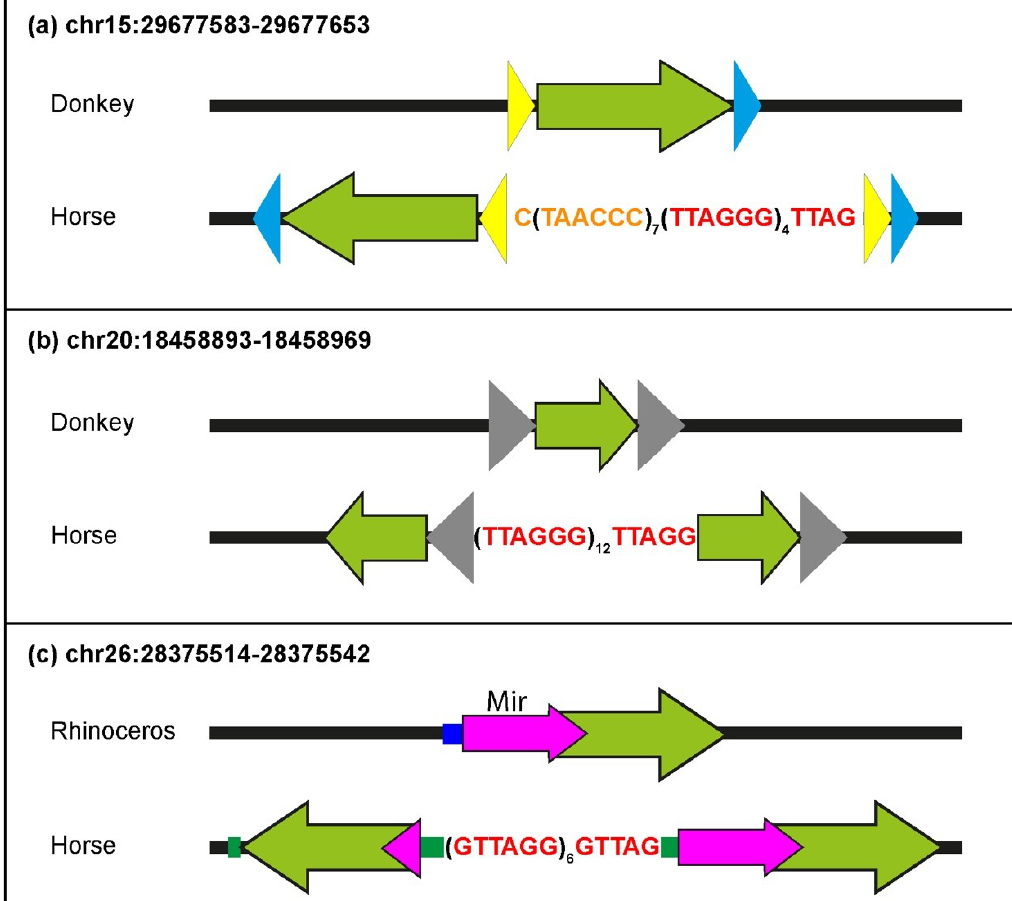
Figure 4. ITS insertions accompanied by complex rearrangements. Telomeric repeat insertions were accompanied by complex modifications of the break site involving addition of random nucleotide sequences, deletion of nucleotides from the insertion site, inversions or generation of inverted duplications. ( a ) Telomeric repeat insertion was accompanied by inversion of a single copy sequence (light green arrow) and generation of inverted duplications (yellow and light blue arrowheads) of sequences present at the empty locus. The rearrangement also caused the formation of telomeric stretches with head-to-head orientation. ( b ) The ancestral ITS-less locus from donkey contains a single copy sequence (light green arrow) flanked by short direct repeats (grey arrowheads). Telomeric repeat insertion at the horse locus was accompanied by duplication and inversion of the upstream direct repeat and of the single copy sequence. ( c ) The empty locus in rhinoceros contains a Mammalian-wide interspersed repeat (Mir, purple arrow) and a single copy sequence (light green arrow). Telomeric repeat insertion was accompanied by deletion of a small sequence from the insertion site (blue strip), duplication and inversion of the single copy sequence and of a portion of the Mir and insertion of small random nucleotide sequences (green